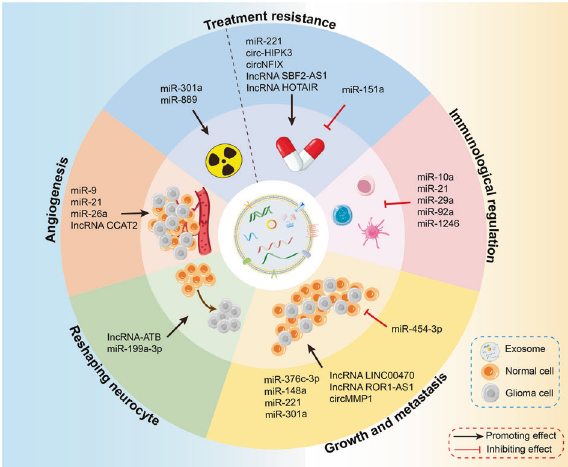
Fig. 4 The biological function of exosomal ncRNAs in glioma. The various types ncRNAs speci fi cally present in exosomes largely depend on their cellular origin. GDE ncRNAs play a key role in cell communication, thus mediating a wide range of glioma processes and possessing a confounding effect on glioma progression. More importantly, GDE ncRNAs can be nonrandomly absorbed by heterologous and homologous cells, affecting post-transcriptional gene regulation and leading to behavioral changes characterized by glioma growth and metastasis, angiogenesis, neurocyte reshaping, immune response, treatment resistance. ncRNA Non-coding RNA, GDE glioma-derived combination with other diagnostic indicators. Thus, GDE ncRNAs represent a huge promising but not yet fully explored source of reliable biopsy biomarkers complementary to the differential diagnosis, monitoring of post-surgical glioma progression, and even the prediction of the patient response to personalized therapies, such as vaccines, antibody drugs, and chemoradiotherapy. It is equally important that the strategy of speci fi cally targeting exosomes or their ncRNA cargoes may be valuable treatment options for the treatment of glioma. Similarly, many studies aim to regulate